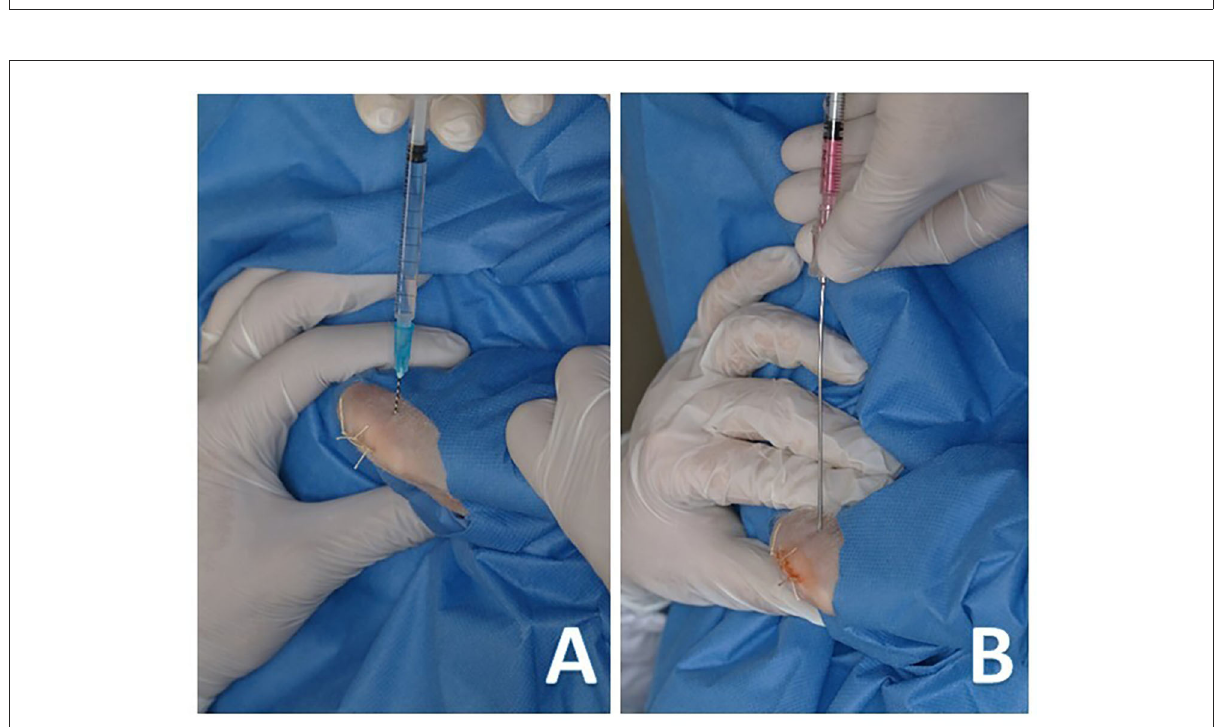
FIGURE2 (A) Intra-articular infiltration of plasma rich growth factors with a 22-G hypodermic needle. (B) Intra-osseous infiltration of adipose derived mesenchymal stem cells with an 18-G spinal